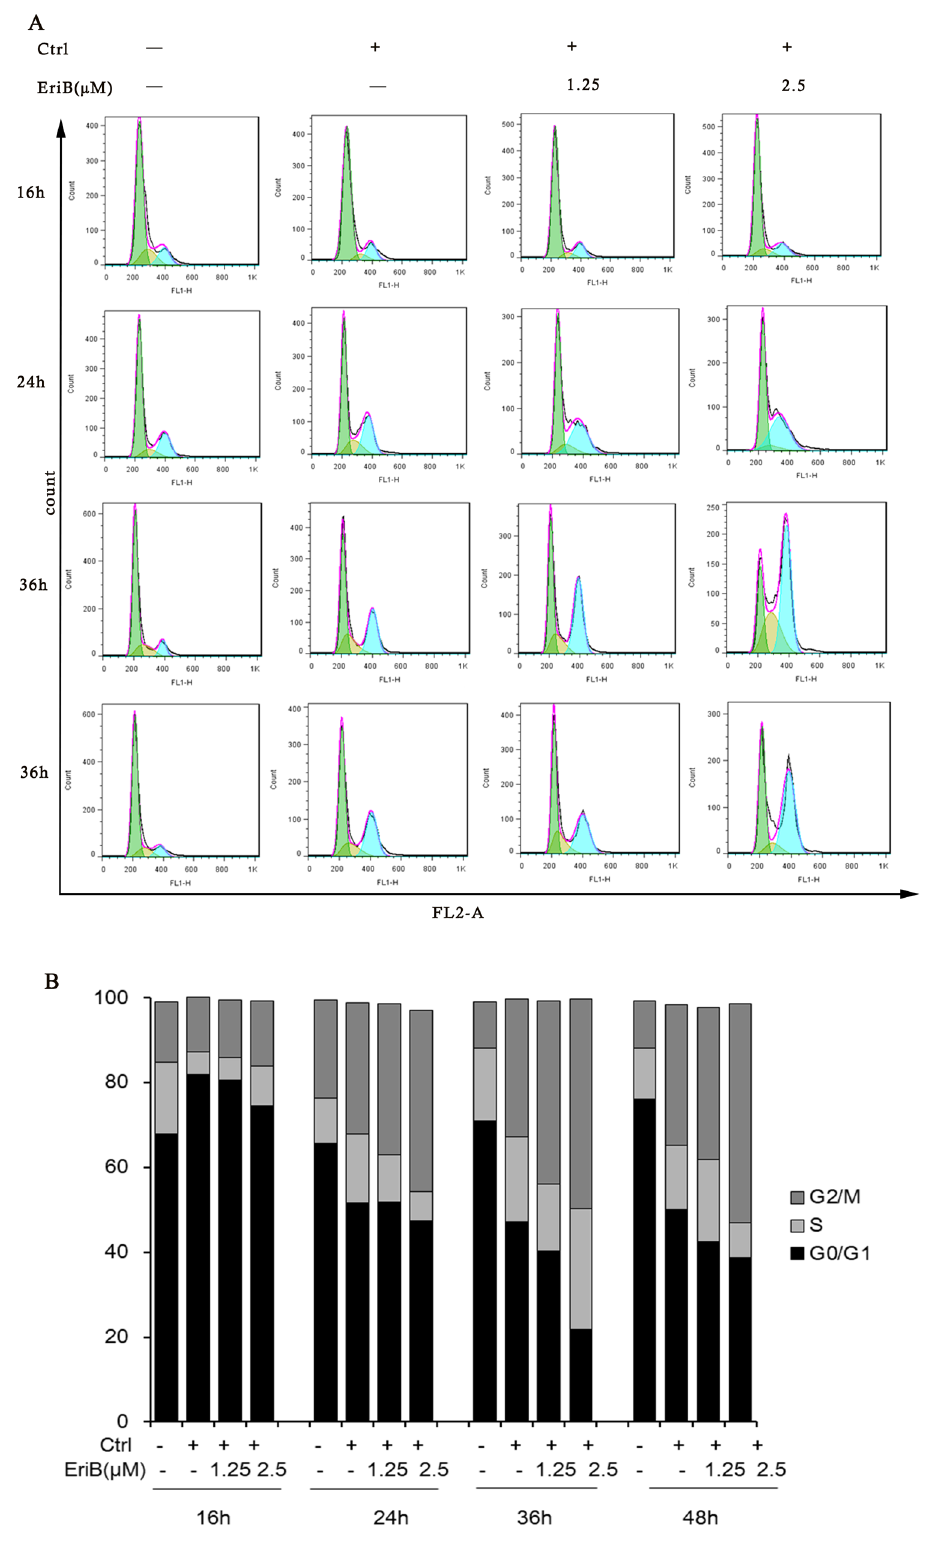
Fig. 4 Eriocalyxin B induced cell cycle arrest at G2/M checkpoint of the MCE period during adipocyte differentia- tion. a Flow cytometry analysis of cells treated with a series of doses of eriocalyxin B for 16, 24, 36 or 48 h. b Quantification of the cells from a . Data were averages of three independent